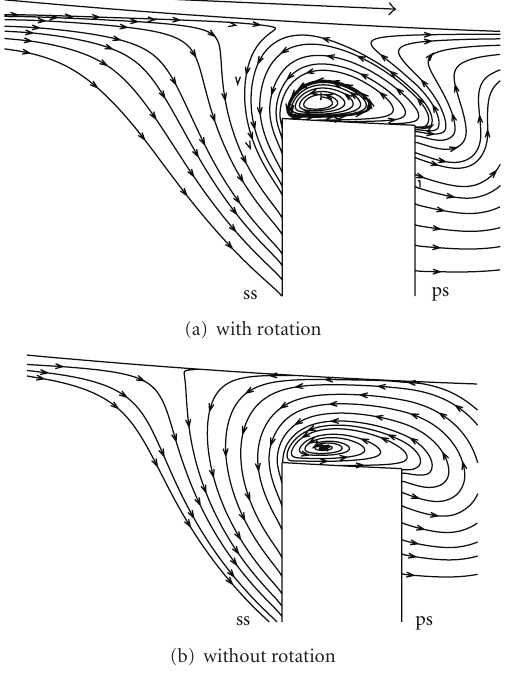
Figure 16: Leakage